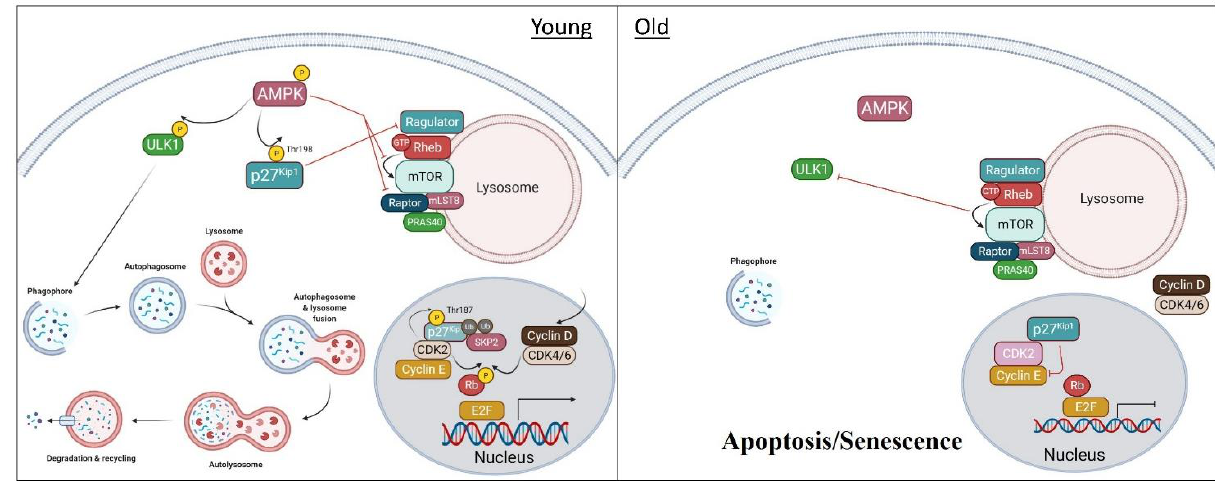
Figure 2. Age-related changes in p27 Kip1 regulation and cellular function. In young cells, pro-survival and autophagy mechanisms are able to activate during cell stress and promote survival and proliferation. The balance between cell anabolism and catabolism is regulated, in part, by the AMPK/mTORC1 pathway. Under nutrient/energy stress, AMPK is phosphorylated, and activated from upstream signaling. This initiates a series of downstream signaling to ULK1 and p27 Kip1 to promote autophagy and prevent apoptosis. AMPK-mediated phosphorylation of ULK1 with start the first step of the autophagy pathway, which is phagosome formation. Phosphorylated p27 Kip1 will inhibit the pro apoptotic protein, Bax while inducing autophagy through inhibition of mTORC1. This is achieved by inhibition of ragulator, a key protein involved in docking mTORC1 regulatory proteins to the lysosome. In addition to the downstream effects, AMPK can directly inhibit mTORC1 by inhibition of mTOR kinase activity and through phosphorylation and inhibition of raptor protein. With proper AMPK activity, p27 Kip1 will accumulate in the cytosol, stimulate autophagy and inhibit apoptosis. In addition, cytoplasmic p27 Kip1 will recruit and import cyclin D/CDK4/6 into the nuclei so it can inhibit Rb and promote entry into the cell cycle. In aged cells, AMPK activation is suppressed during cellular stress. This results in hypophosphorylation of AMPK and loss of kinase activity. The inability to phosphorylate and stabilize cytosolic p27 Kip1 will promote its sequestering in the nuclei and/or degradation of cytoplasmic p27 Kip1 . In the nuclei, p27 Kip1 will inhibit cyclin E/CDK2 and suppress gene expression of cell cycle proteins. Furthermore, the lack of phosphorylated ULK1 and p27 Kip1 leads to a reduction in autophagy and susceptibility to apoptosis. The lack of mTORC1 inhibition will further inhibit ULK1 and autophagy.